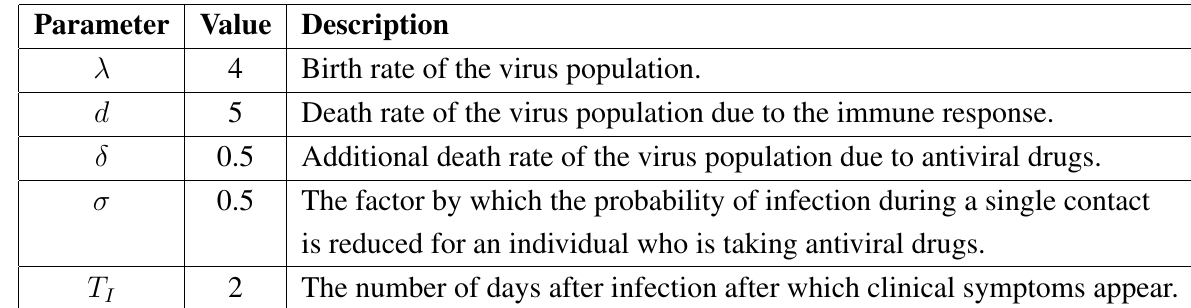
Table 1. Values of the model